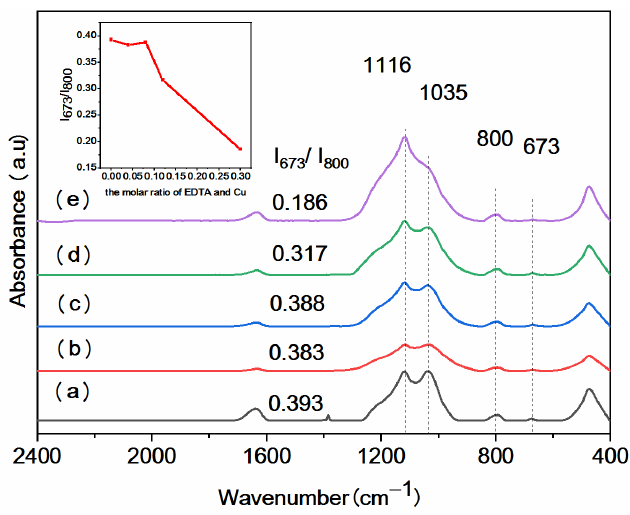
Figure 5. FT-IR spectra of the calcined catalysts. (a) Cu/SiO 2 , (b) 0.04E-Cu/SiO 2 , (c) 0.08E-Cu/SiO 2 , (d) 0.12E-Cu/SiO 2 , (e) 0.3E-Cu/SiO 2 . (d) 0.12E-Cu/SiO 2 , (e) 0.3E-Cu/SiO 2